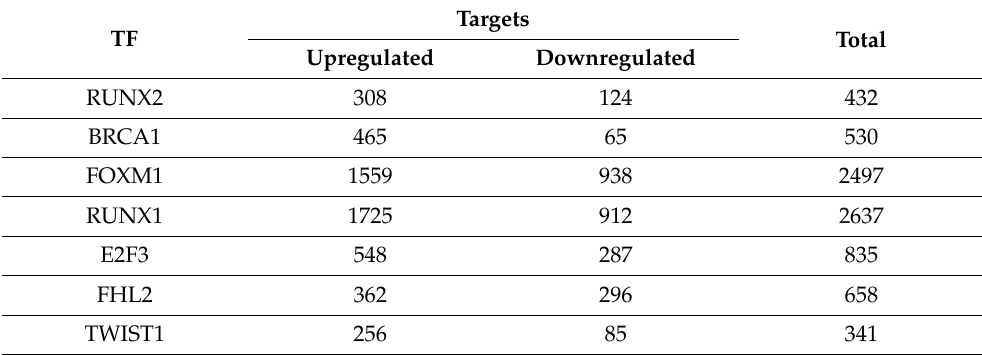
Table 3. According to the RTN library analysis, target genes of the RUNX2 transcriptional regulator and its coregulators, E2F3, FHL2, TWIST1 BRCA1, FOXM1, and RUNX1. TF